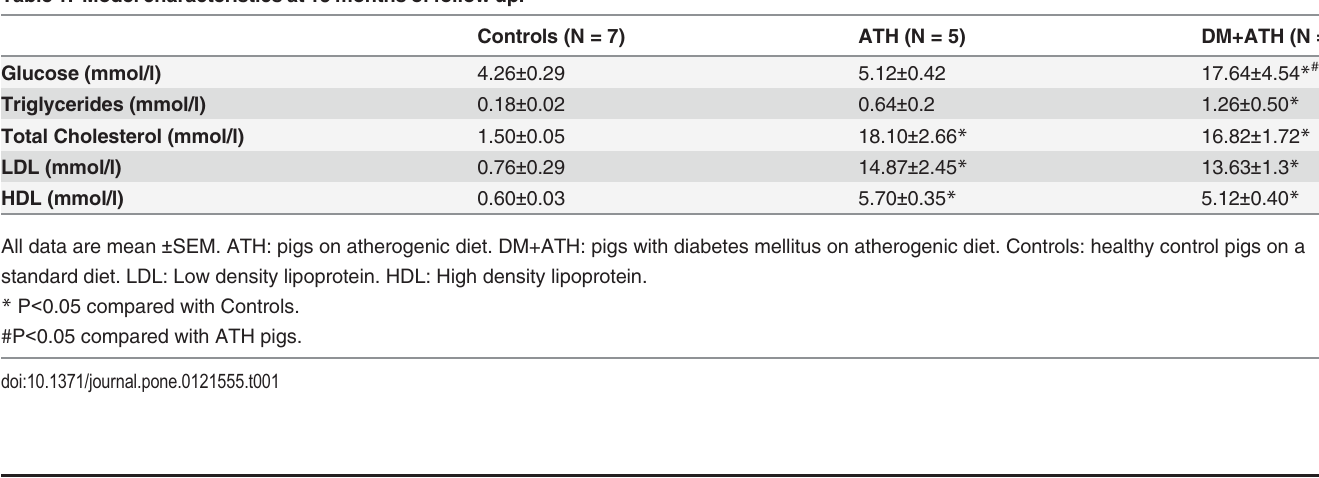
Table 1. Model characteristics at 15 months of follow